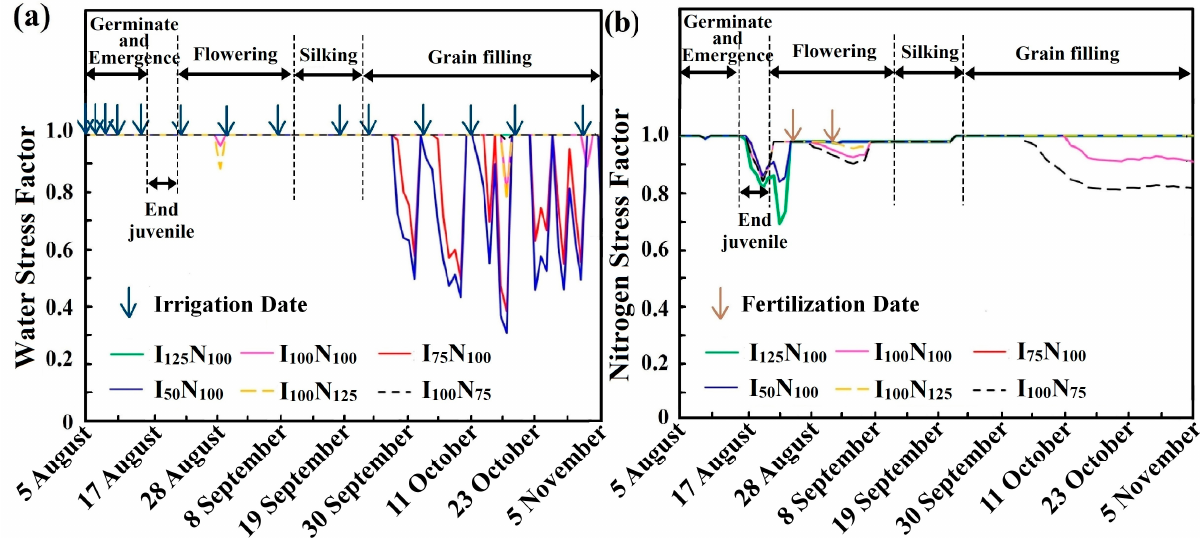
Figure 4. The WSF (a) and NSF (b) response to six SDF scenarios. WFS: water stress factor. NSF: nitrogen stress factor. WFS and NSF = 1 indicate that there is no water and N stress, respectively. WFS and NSF < 1 indicate some water and N stress. Other notations used in this table are the same as those in Table 1.